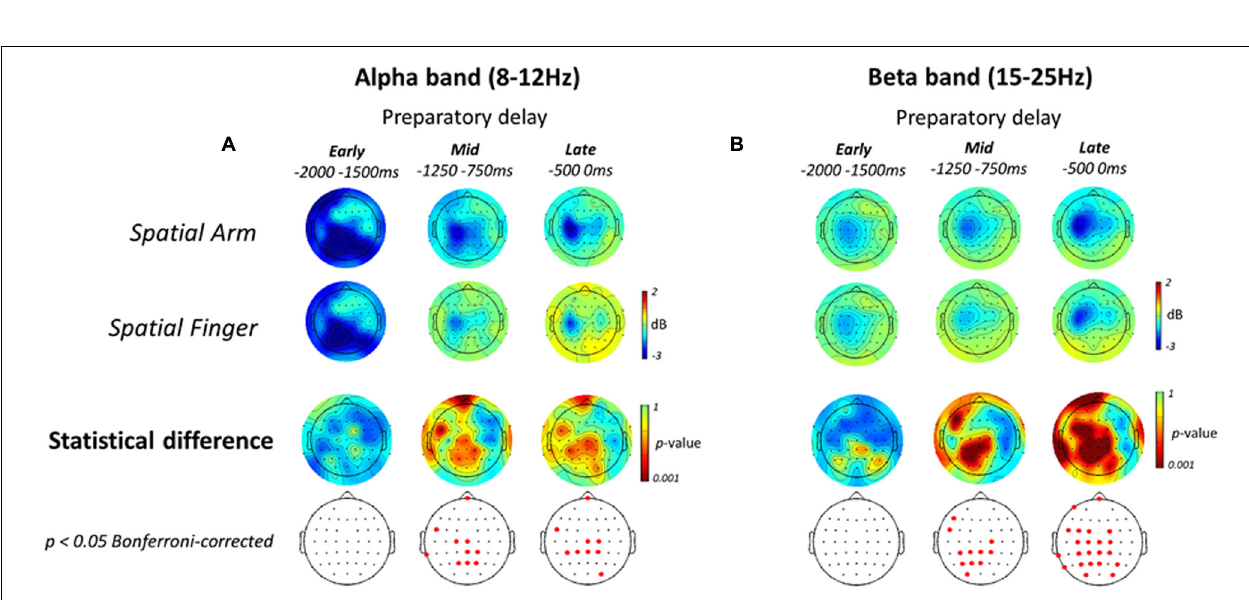
Frontiers in Human Neuroscience |